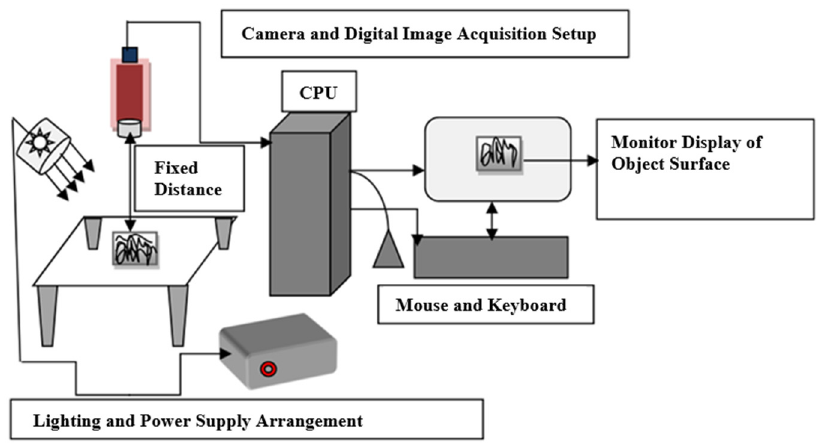
Figure 9. The testing device based on machine vision with permission from [69], 2018, Elsevier.